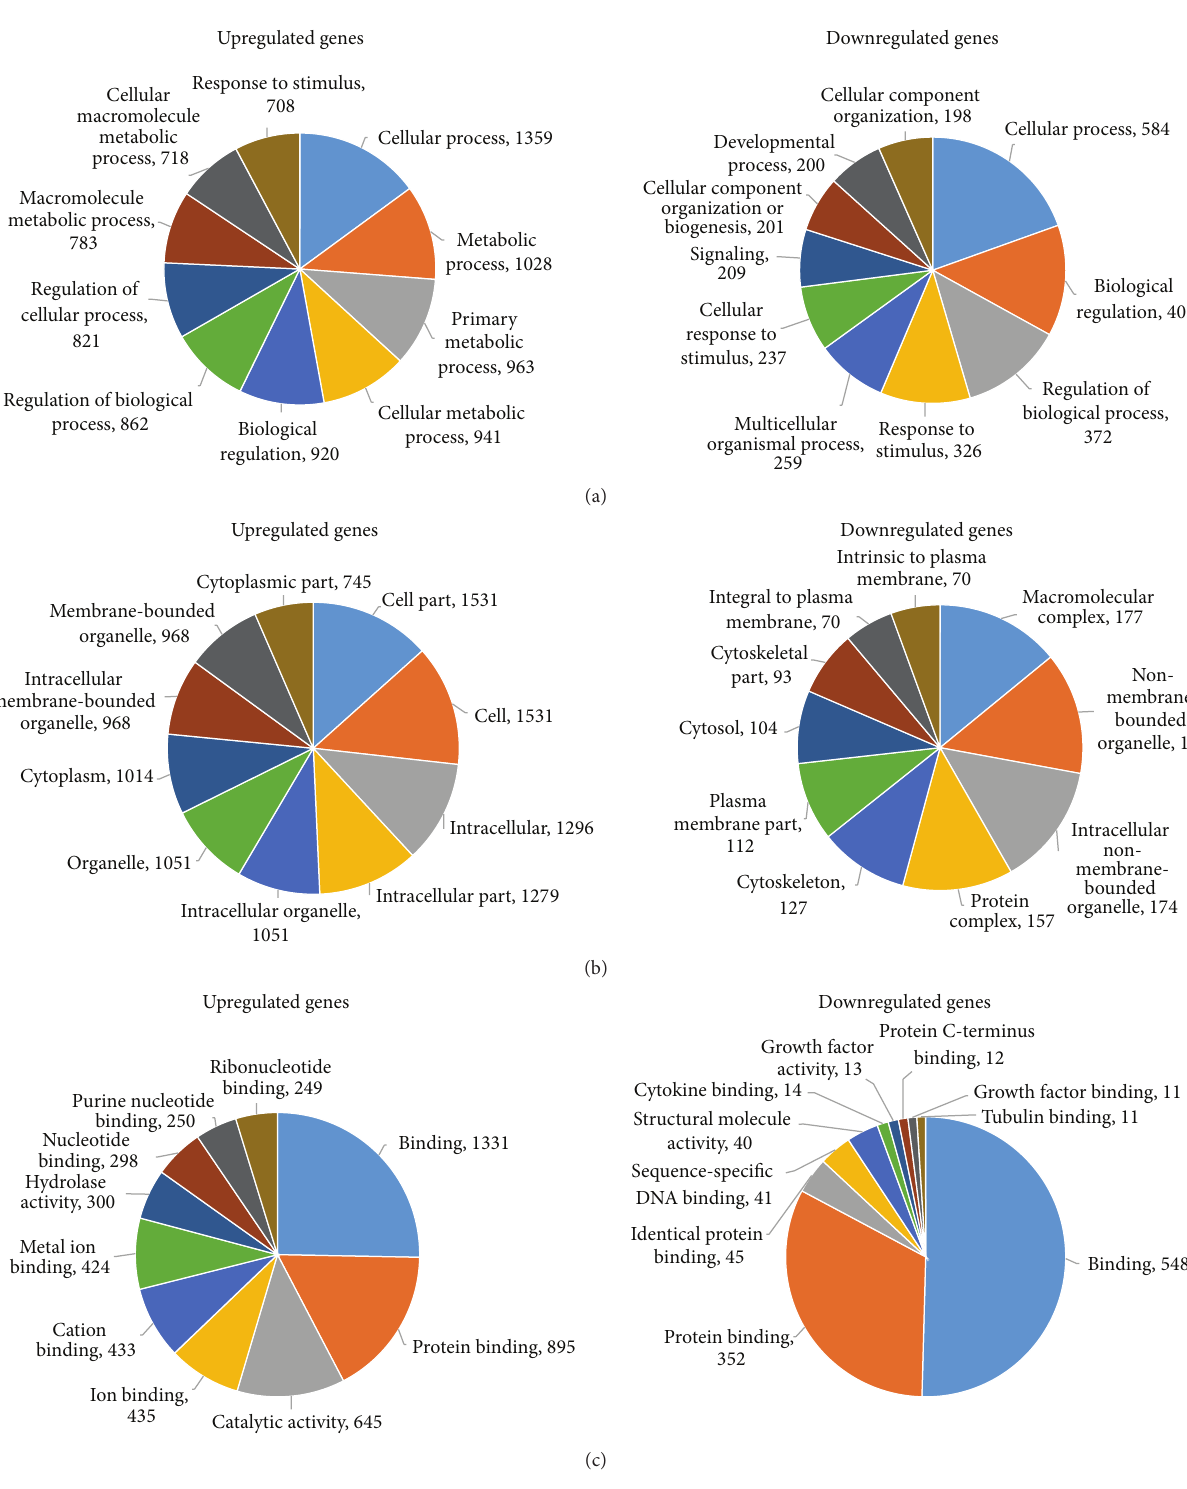
Figure 4: Gene Ontology (GO) analysis results of the genes differentially expressed in SMSCs from RA patients and HDs. Counts of the top ten significantly enriched terms of upregulated and downregulated genes in the biological process, cellular component, and molecular function domains are shown in (a), (b), and (c),